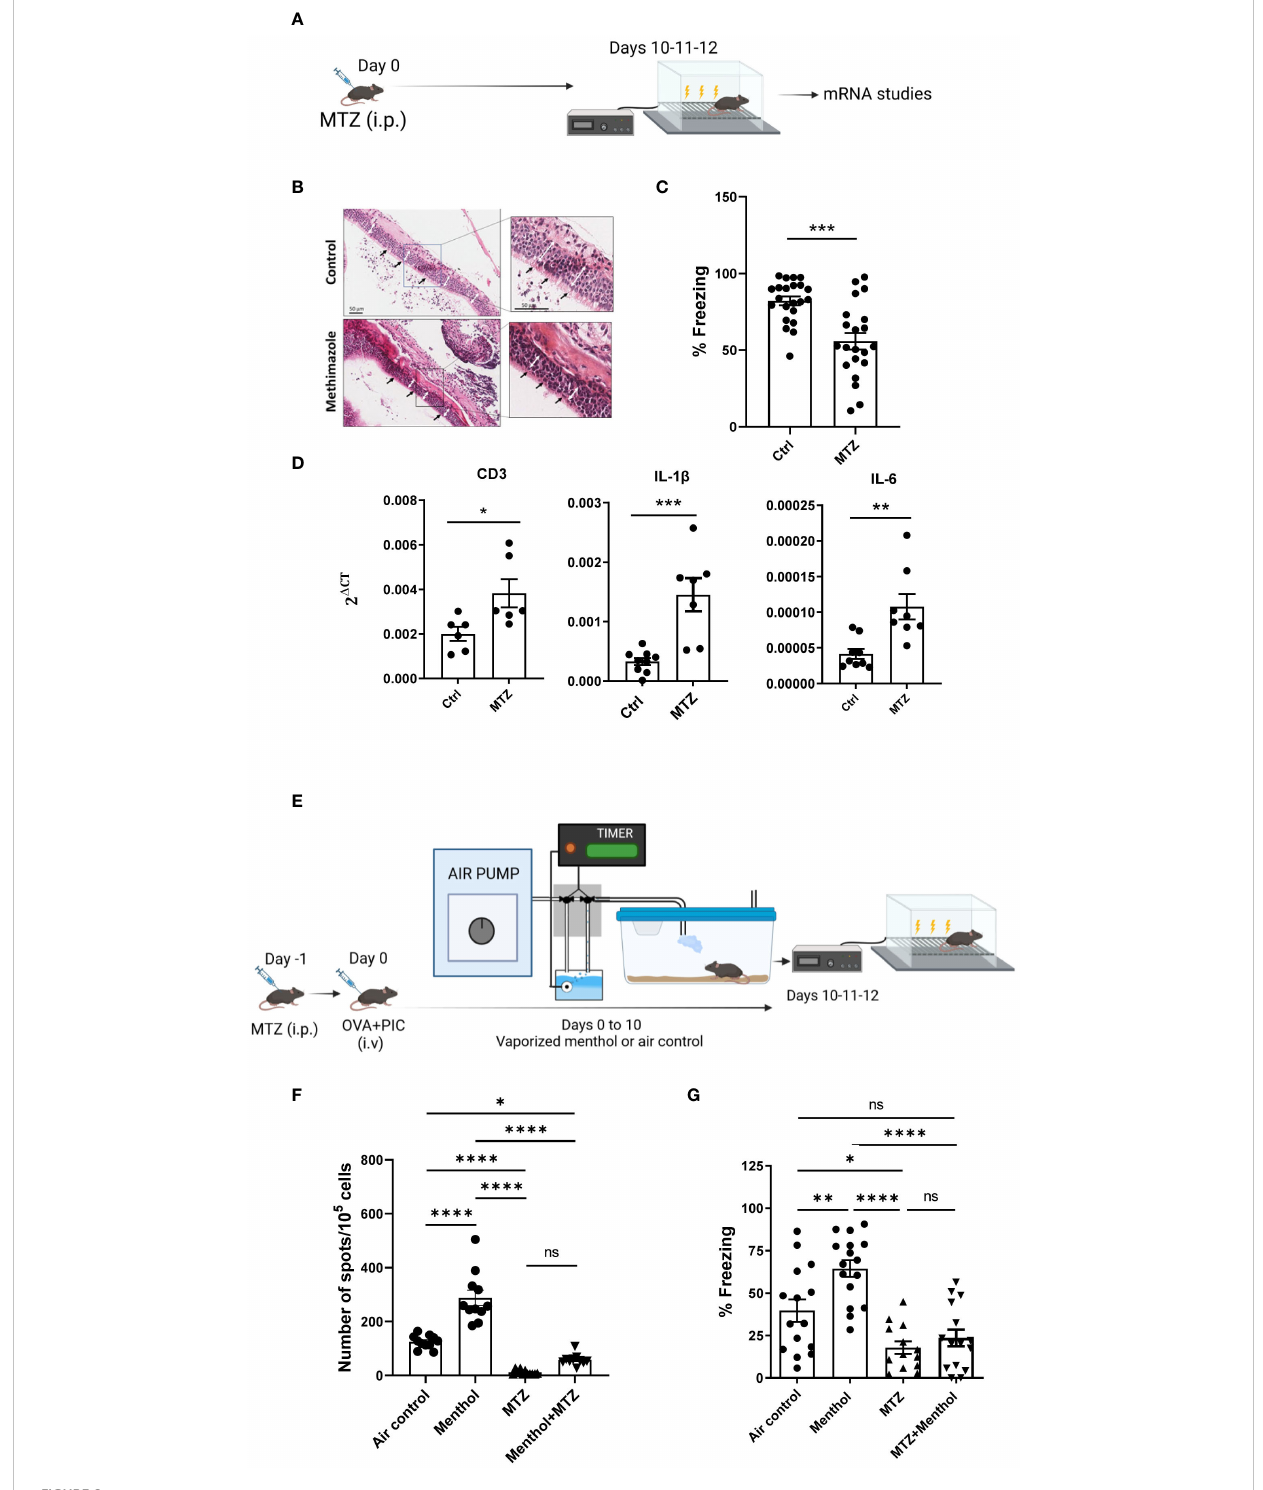
FIGURE 2 Effect of methimazole (MTZ) treatment in cognitive capacity and the immune system in C57BL/6 mice. (A) Schematic depicting the experimental procedure analyzed in (B – D) C57BL/6 female mice were treated with a single injection of MTZ i.p. and 10 days later, olfactory epithelia were isolated and stained by H&E (B) . Cilia atrophy (black arrows) and epithelial thickness (white arrows) in the olfactory epithelium from methimazole treated mice compared to the epithelium of control mice is indicated. (C) Fear memory evaluated in mice treated or not with MTZ. (D) mRNA for CD3, IL-1 b or IL-6 was measured in mRNA samples obtained from prefrontal cortex of the indicated groups of mice. (E) Schematic depicting the experimental procedure analyzed in F and (G) Naïve or MTZ treated C57BL/6 mice were immunized with ovalbumin plus Poly I:C. and seven days after immunization IFN- g producing cells speci fi c for SIINFEKL peptide measured by ELISPOT (F) . (G) Fear conditioning assay for the indicated groups of mice. Data were analyzed with student ’ s t-test (C, D) and one-way ANOVA (F, G) . ****p<0.0001, ***p<0.005, **p<0.01, *p<0.05. ns, not signi fi